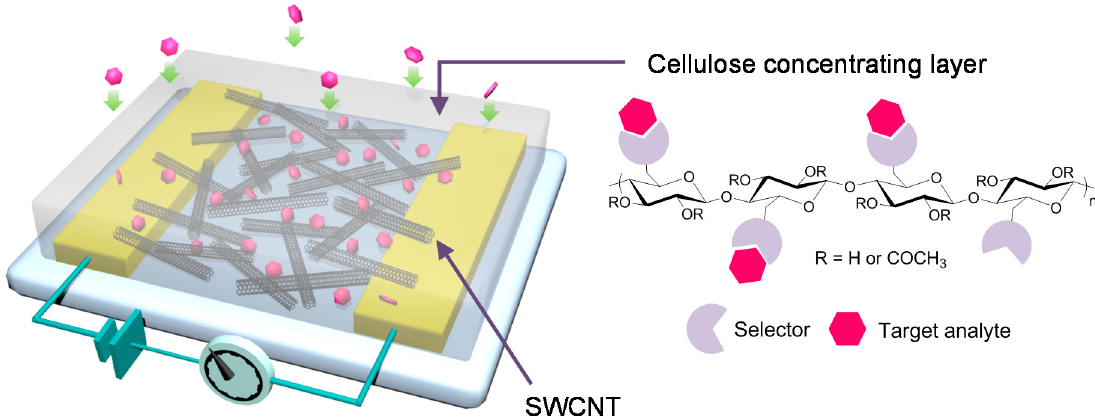
Figure 1. Schematic diagram of the integrated polymer concentrator/single-walled carbon nanotubes (SWCNT) sensing system: cellulose concentrating layer absorbs, concentrates, and delivers analytes as near as possible to the SWCNT sensing layer within a few seconds.